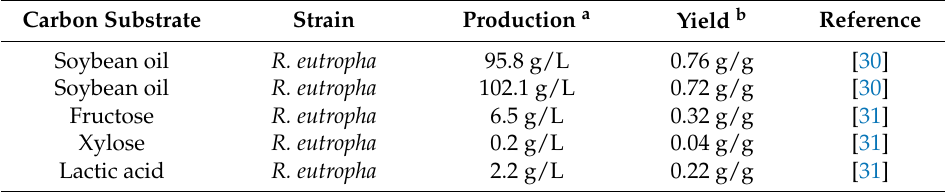
Table 1. Microbial production of polyhydroxyalkanoates (PHA) from variable carbon substrates. Carbon Substrate Strain Production a Yield b Reference Soybean